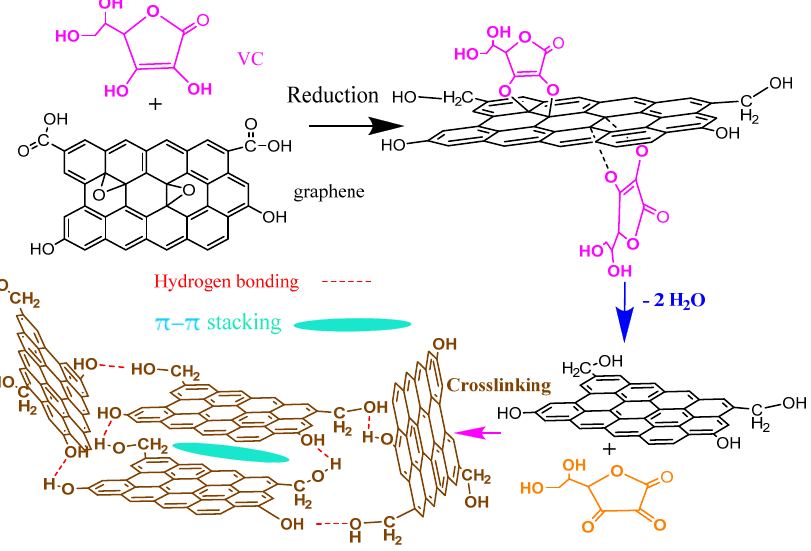
Figure 6. Working mechanism of VC reduction and